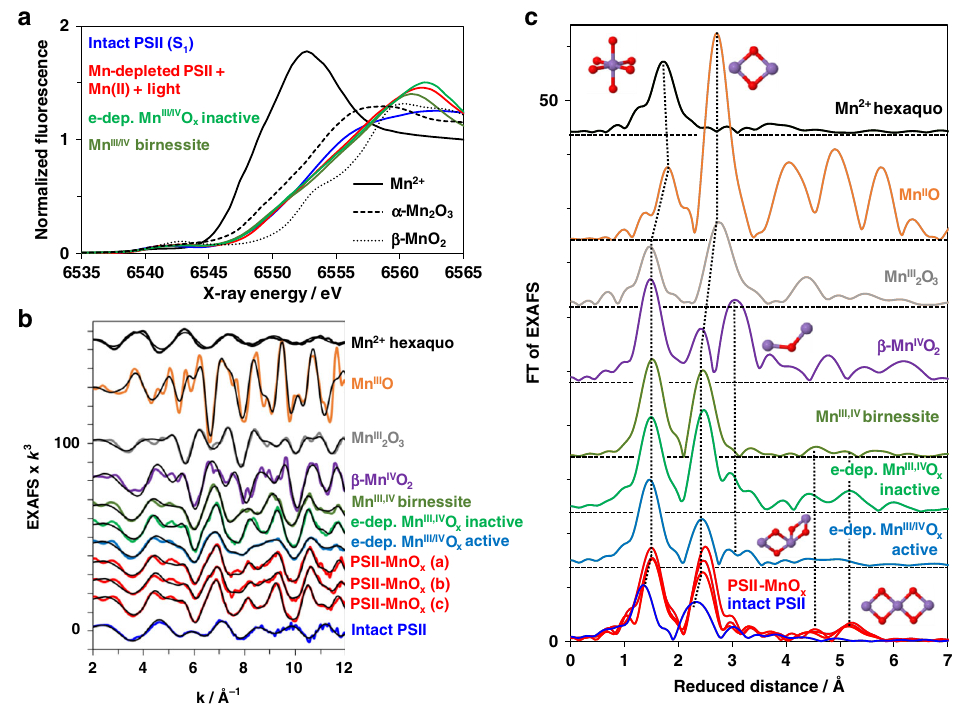
Fig. 5 X-ray absorption spectroscopy evidencing PSII-bound Mn oxide of the birnessite-type. a XANES spectra of the native PSII with its active-site Mn (III) 2 Mn(IV) 2 CaO 5 cluster (blue line) and Mn-depleted PSII after the light-driven formation of Mn oxide (red lines) are compared to the spectra of Mn 2 + in solution (solid black line), electrodeposited Mn oxide (green line), synthetic birnessite (dark green line) and further Mn oxides (dashed and dotted black lines). b The corresponding EXAFS spectra in k -space as in a as well as spectra of further Mn compounds. c Fourier-transformed (FT) EXAFS spectra (as in b ) of: Mn 2 + ions in solution, indicated reference Mn oxides, the Mn 4 CaO 5 cluster in intact PSII, and Mn-depleted PSII after illumination in the presence of Mn 2 + . Structural motifs corresponding to the individual peaks are schematically shown; FT peaks relating to the same structural motif are connected by dotted lines. Mn-depleted PSII particles (20 µ g mL − 1 chlorophyll) were illuminated for 3 min (1000 µ E m − 2 s − 1 ) in the presence of 240 µ M MnCl 2 and 60 µ M PPBQ (buffer conditions: 1 M glycine-betaine, 15 mM NaCl, 5 mM CaCl 2 , 5 mM MgCl 2 , 25 mM MES buffer, pH 8.5; similar data for pH 7.0 is shown in Supplementary Fig. 15) and subsequently collected by centrifugation. (The spectrum shown in a as a red line represents the mean of the three spectra from individual samples shown in b and c as red lines as obtained after subtraction of a 5 % aqueous Mn 2 + contribution. See Supplementary Table 2 for details and further data.) Source data are provided as a Source Data fi